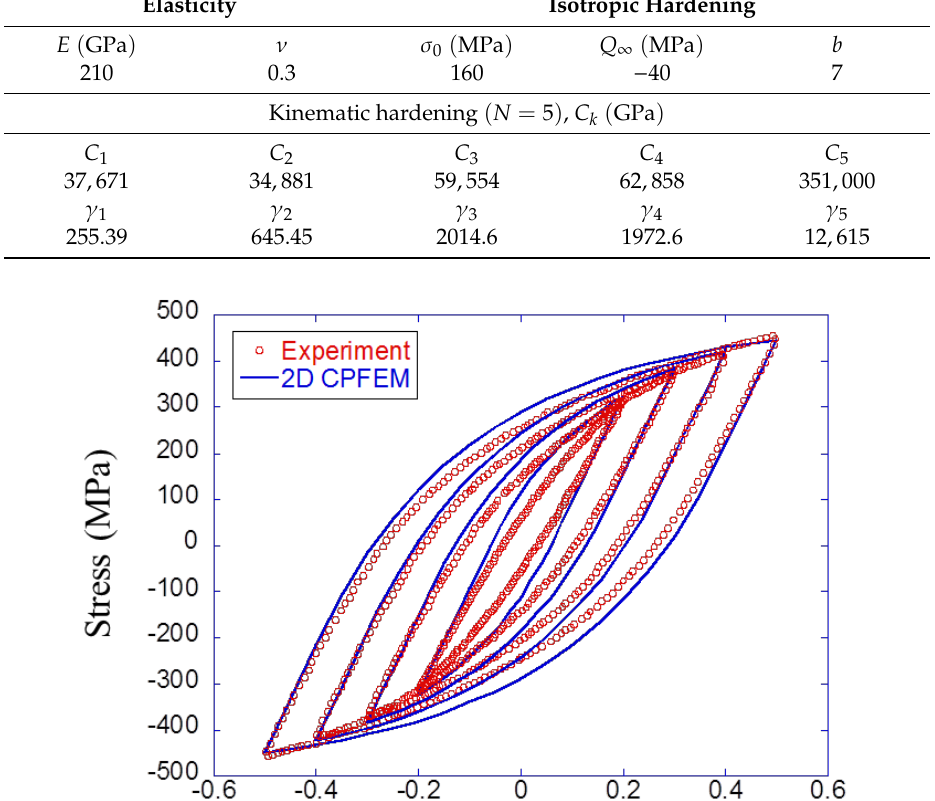
Table 3. Finite element analysis parameters of pearlite.